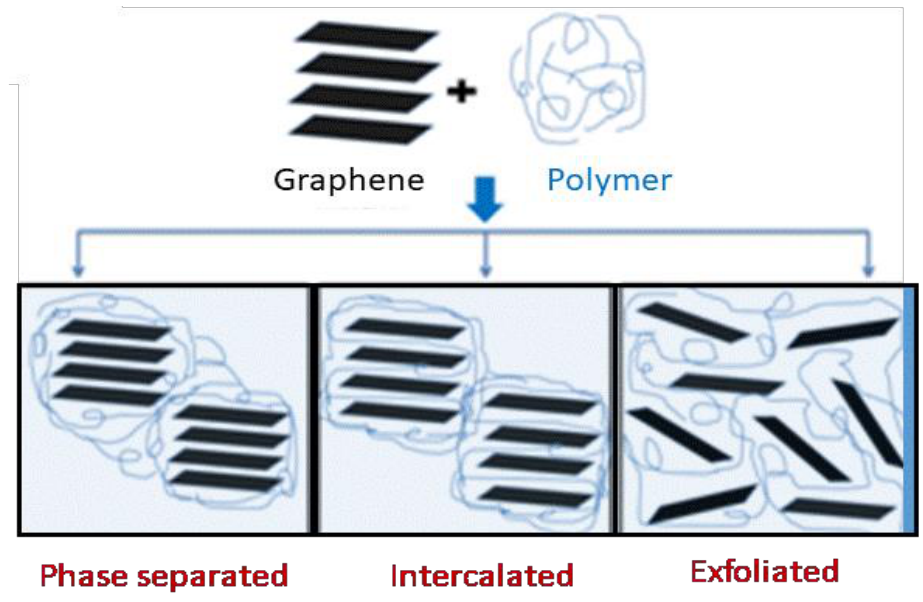
Figure 8. Schematic illustration of different types of graphene – polymer nanocomposites.